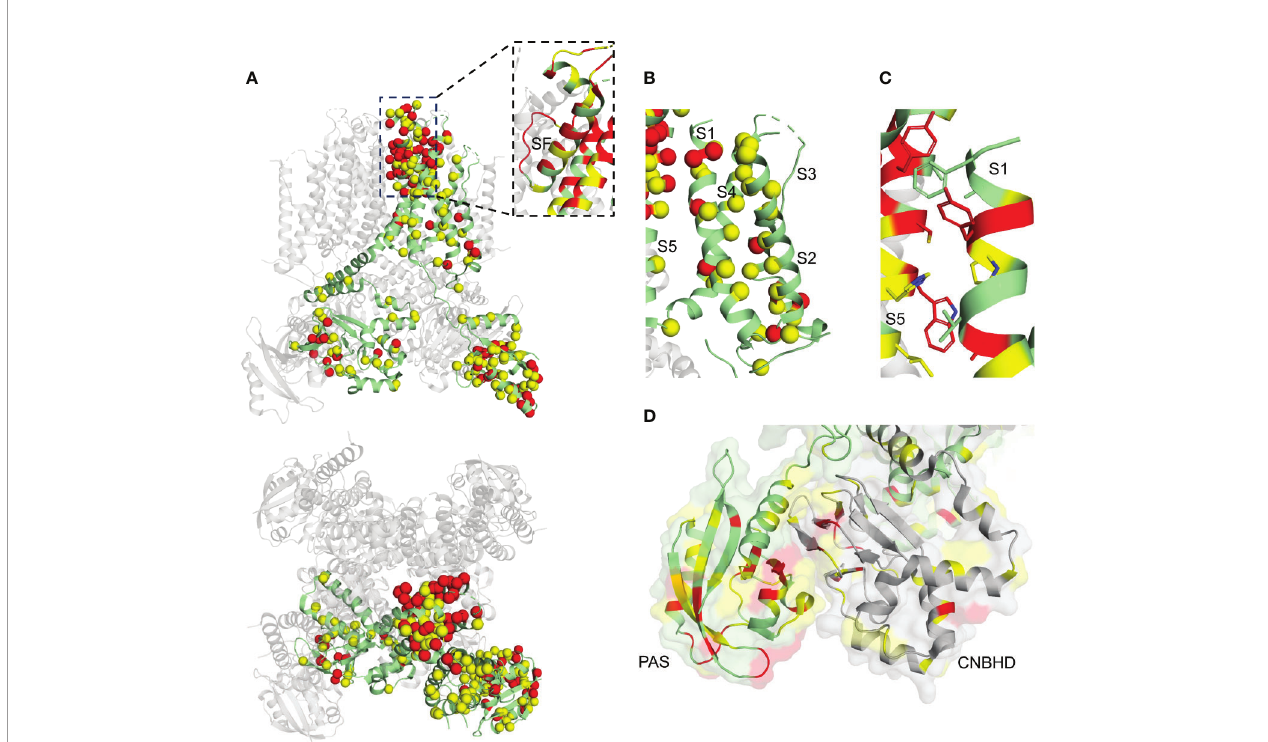
FIGURE 10 | hERG structure with deleterious mutation sites indicated. (A) Full hERG structure (PDB: 5VA1) (Wang and Mackinnon, 2017). Yellow sites denote locations of a single deleterious mutation, while red indicates sites with multiple mutations identi fi ed. Spheres indicate C-alpha positions of mutation sites. Subunit with LQT2 mutations sites mapped is colored green. Inset: close-up of SF and pore helix. (B) hERG VSD. (C) . Close-up of the S1/S5 interface. Residues at the interface are indicated with sticks (D) N-terminal PAS (dark gray) and C-terminal CNBHD (light gray) domain interface, cartoon representation with surface representation overlay. One subunit is green and the other gray, for clarity.